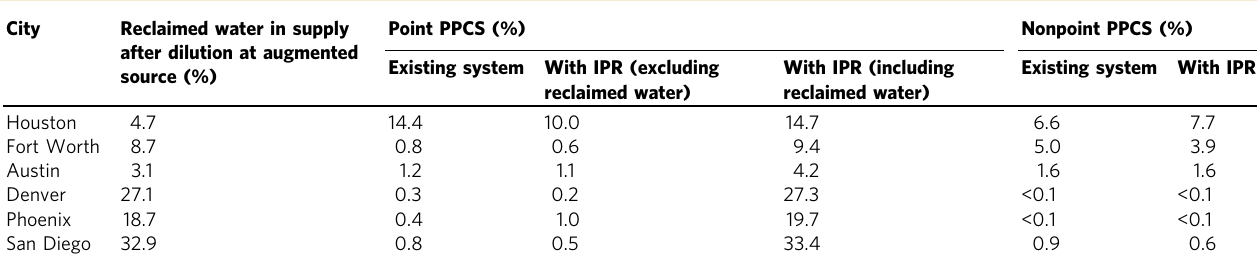
Table 2 Hypothetical IPR (meeting one third supply) for six selected cities and its impacts on proportion of reclaimed water in supply (%) (after dilution with natural fl ow at the augmented source) and PPCS